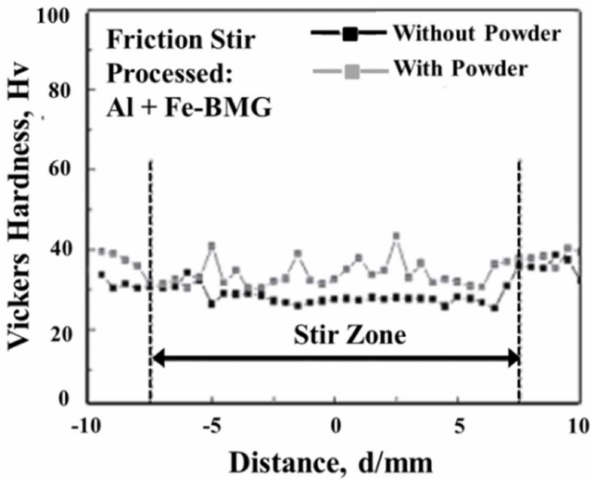
Figure 16. Hardness distribution on a cross section perpendicular to the friction stir processing direction in pure aluminum reinforced with Fe 72 B 14.4 Si 9.6 Nb 4 metallic glass [42]. (Open Access).